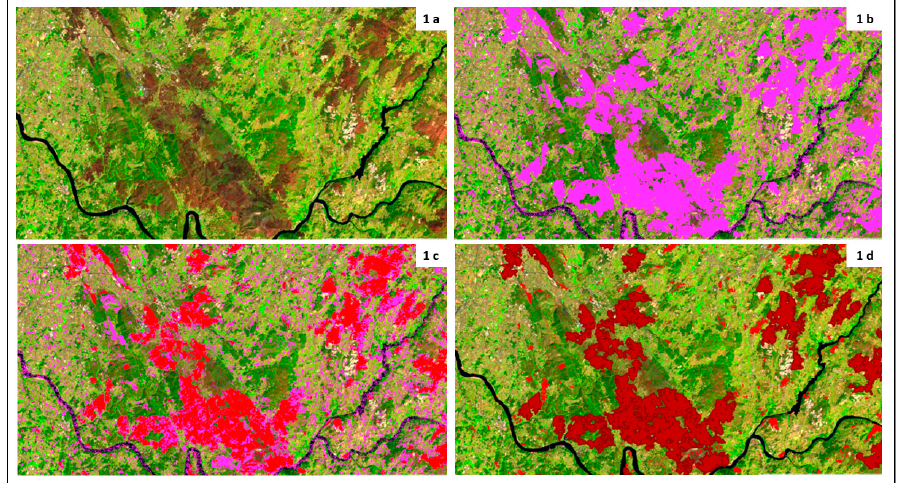
Figure 7. Illustration of burnt area classification. ( 1a ) Landsat RGB 542 image, path/row: 204/031, date 18 September 2005; ( 1b ) Landsat image with mask of possible burnt areas built from the superimposed harmonic model adjustment. ( 1c ) Landsat image with mask of possible burnt areas and burnt area classification overlaid (the mask in purple, the fires in red); ( 1d ) Landsat image with burnt area classification overlaid (the whole burnt area in red, the fires larger than 100 ha in dark red).